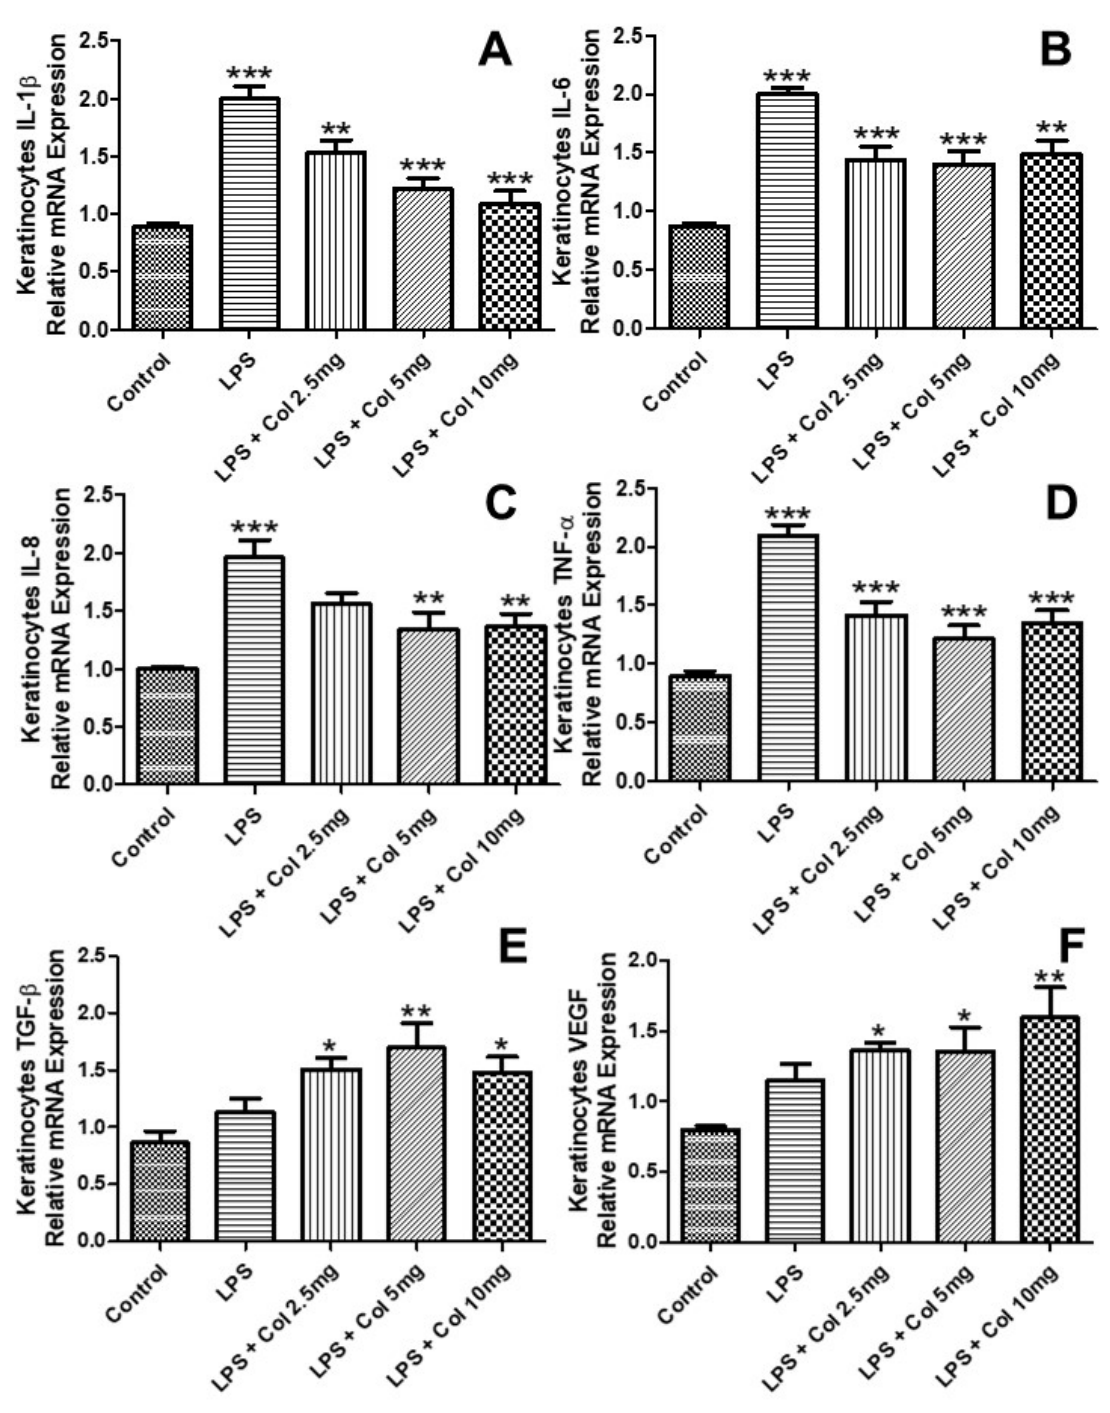
Figure 4. The effects of collagen supplementation on the mRNA expression of IL-1β ( A ), IL-6 ( B ), IL-8 ( C ), TNF-α ( D ), TGF-β ( E ), and VEGF ( F ) of human keratinocytes. For ( A ), *** p < 0.001 compared with the control group and LPS group and ** p < 0.01 compared with the LPS group. For ( B ), ** p < 0.01; *** p < 0.001 compared with the control and LPS groups. For ( C ), *** p < 0.001 compared with the control group and ** p < 0.01 compared with the LPS group. For ( D ), *** p < 0.001 compared with the control and LPS groups. For ( E , F ), ** p < 0.01 and * p < 0.05 compared with the control